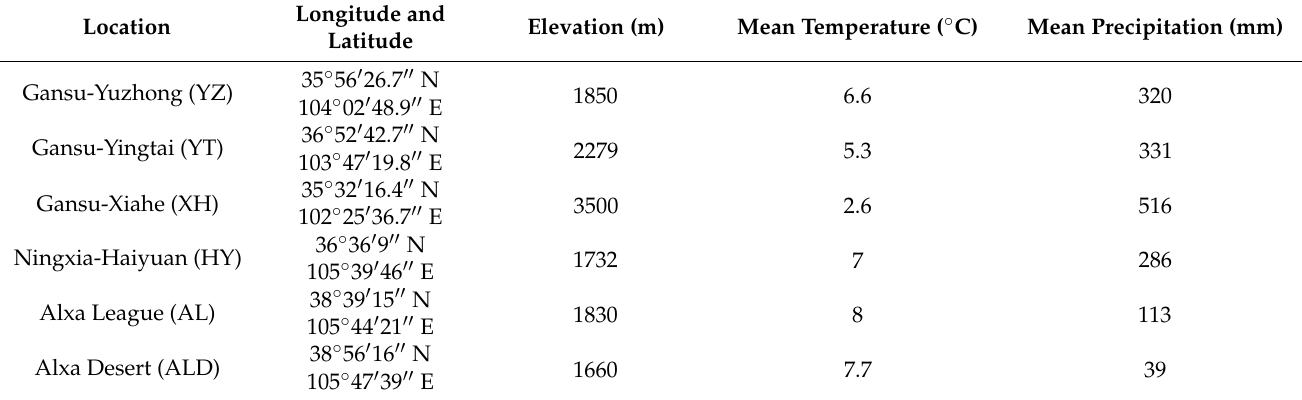
Table 1. Origins of Achnatherum inebrians plant lineages and their attributes.